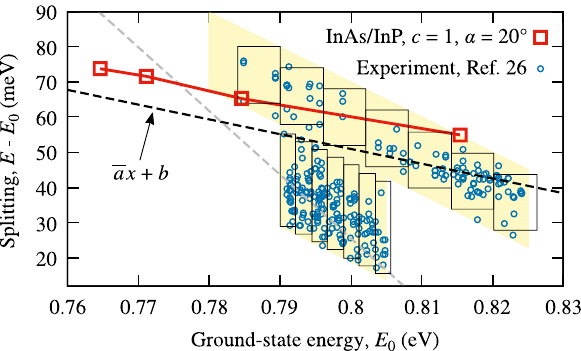
Figure 7. Comparison with experimental data. Circles present results from Ref. 26 showing the energy of optically active excited states of charged excitons in InAs/InP QDs as a function of emission energy obtained in the photoluminescence excitation experiment. Squares show results of this work repeated from Fig. 6. The shaded area shows the range of energies that were accessible in the experiment. Rectangles mark subareas used here to evaluate the average slopes of the data; dashed lines show the resultant average